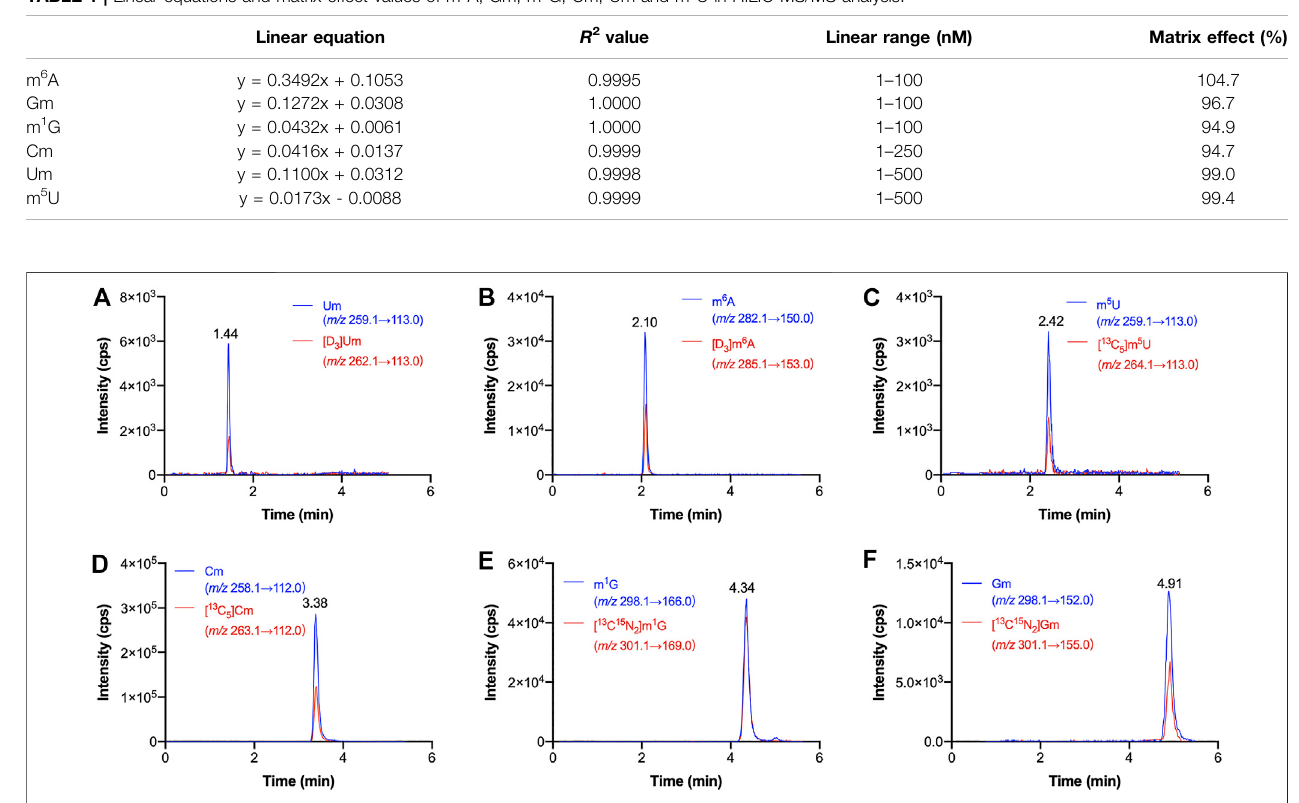
FIGURE3| RepresentativeMRMchromatogramsof (A) Um, (B) m 6 A, (C) m 5 U, (D) Cm, (E) m 1 G, (F) Gmandspikedisotope-labeledinternalstandardsinaserum